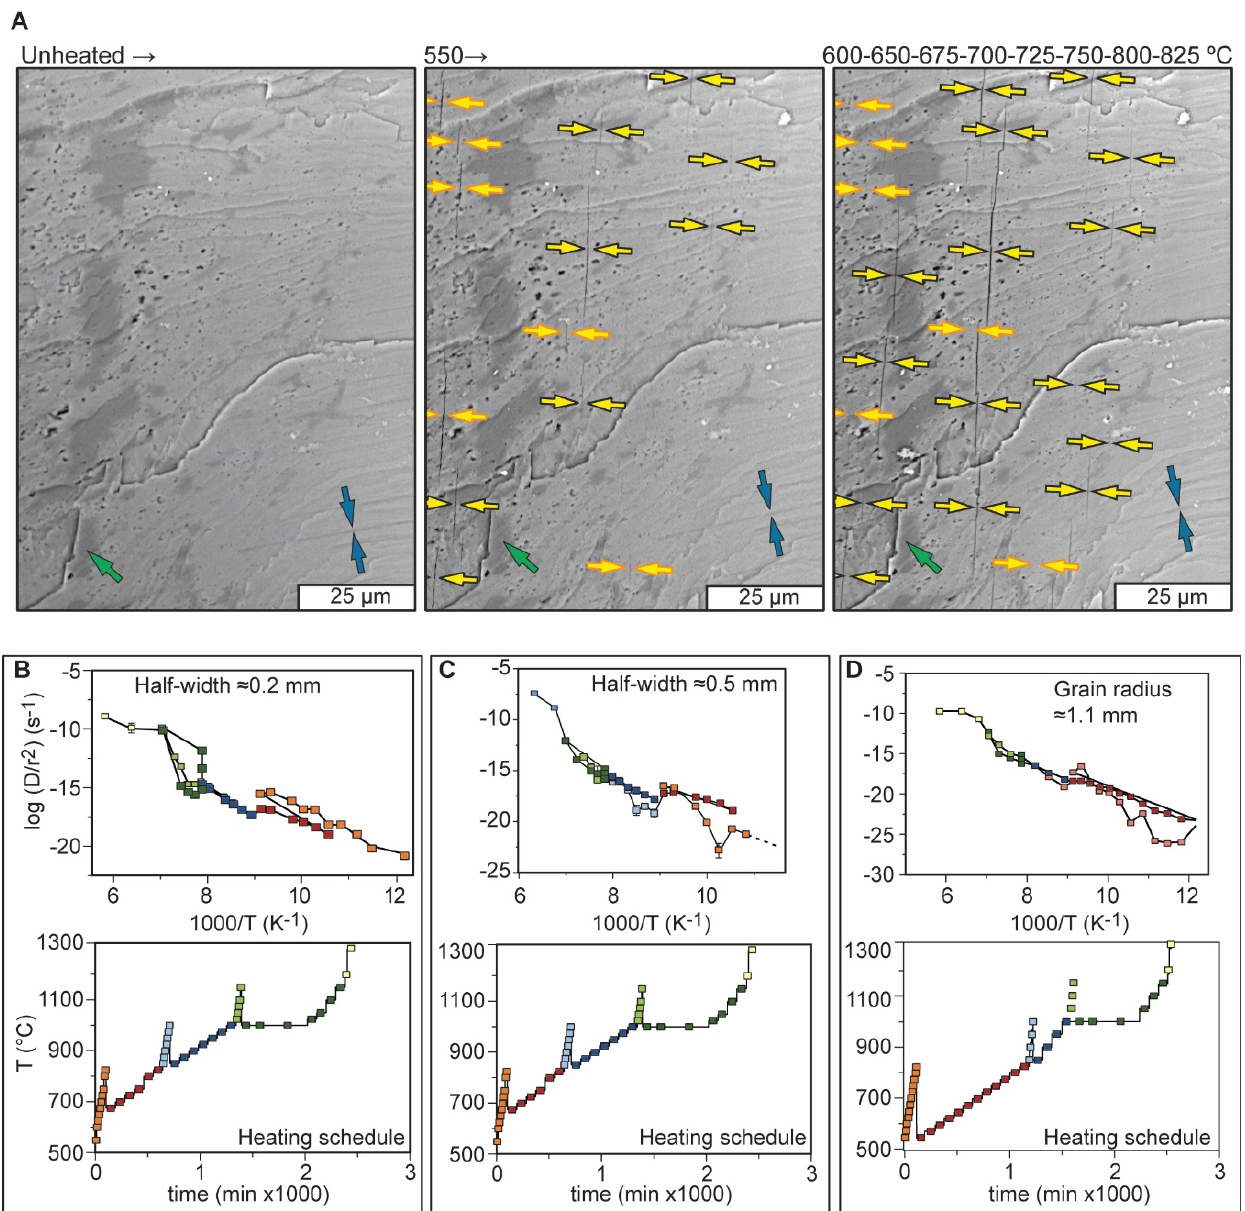
Figure 7. ( A ) Back-scatter electron images of uncoated (010) cleavage surfaces of an alkali feldspar fragment taken from the Shap Granite, UK. The images were taken in the same region before step-heating (left), after a single 10 min heating step at 550 °C (middle) and after an additional eight heating steps at 600–825 °C (right). Blue arrows show exsolution lamellae. Green arrows highlight replacement perthite veins (dark regions are Na-rich, brighter regions are K-rich). Yellow arrows show cracks: black outline indicates cracks that did not disappear with progressive heating, orange outline indicates cracks that appeared after 1 heating step and became invisible after 9 heating steps. ( B – D ) Arrhenius plots for the step/heating experiments with the corresponding repetitive heating schedules. The Arrhenius trajectory of smaller grains is consistent with MDD theory, while grains with half widths of 0.5 mm and larger yield smaller values for D/r 2 for higher temperature heating steps, which is contradictory to MDD theory. Non-linearity in the Arrhenius trajectories was ascribed to the evolution of fracturing during step-heating. All data and images are taken from Popov et al. (2020b) [17].